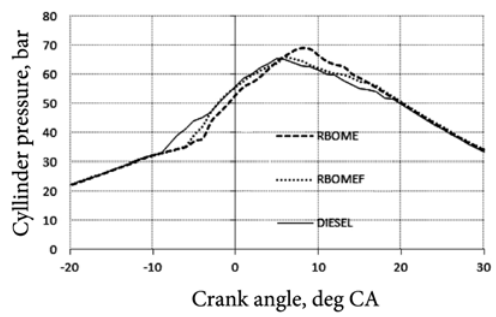
Fig. 7. Variation of pressure with crank